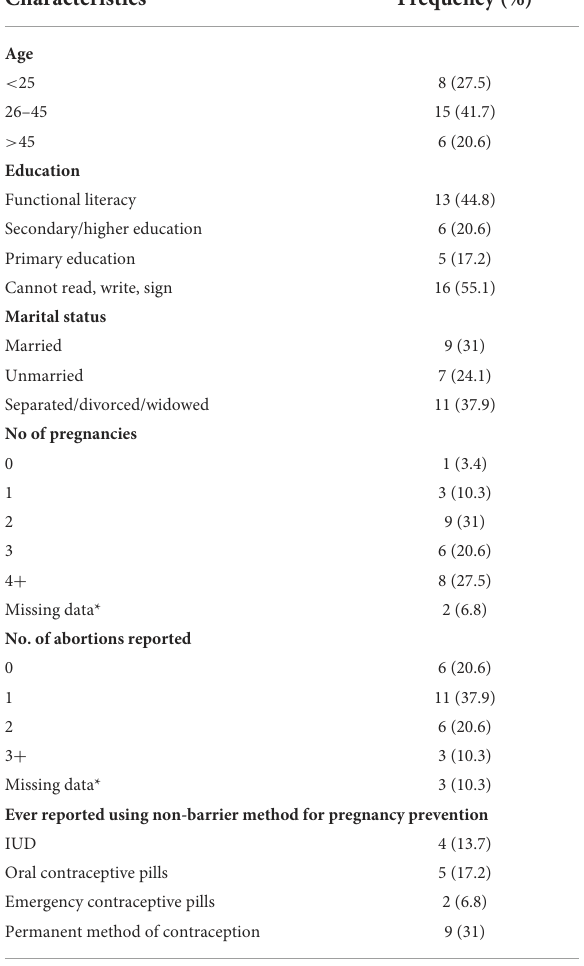
TABLE 1 Demographic characteristics of FSW